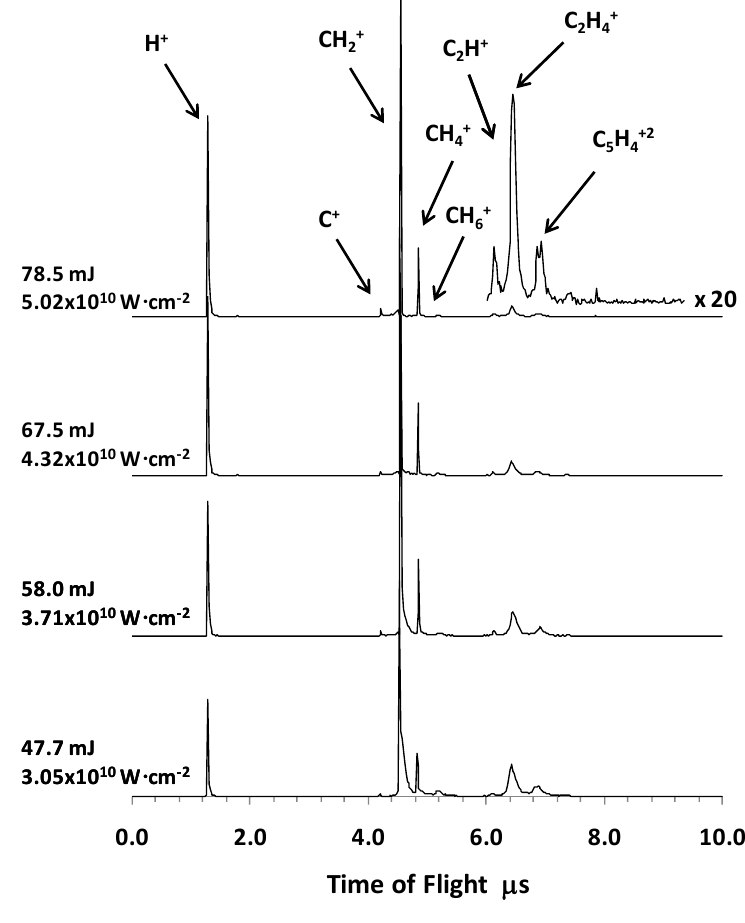
Figure 1. Photodissociation ToF spectra at 355 nm, without carrier